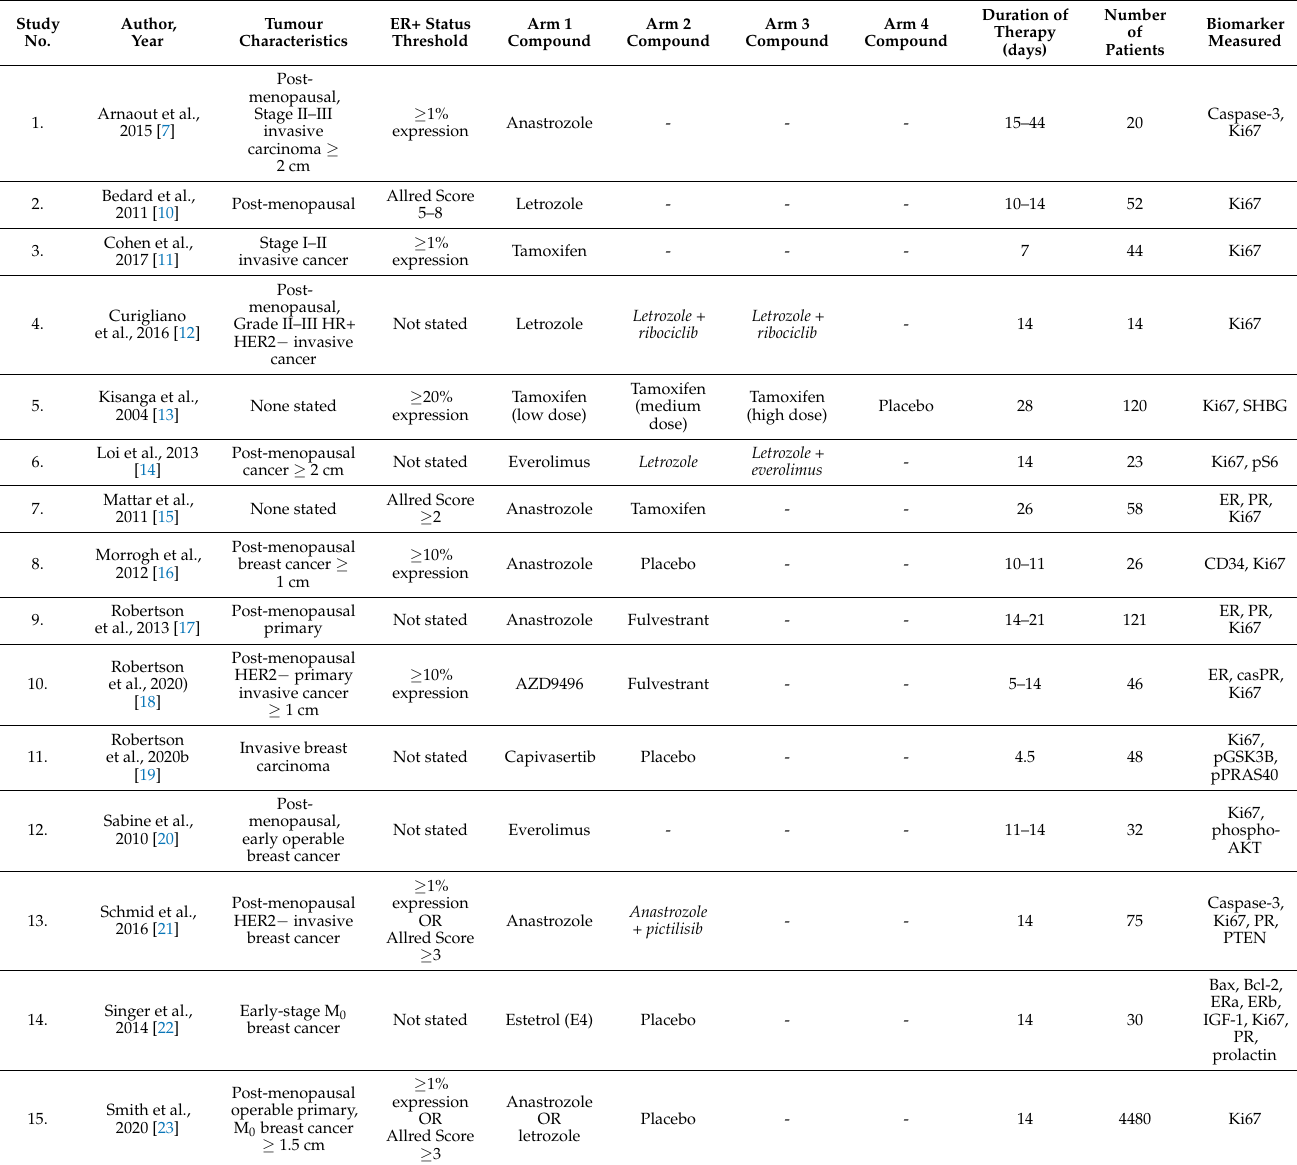
Table 1. Summary of the study characteristics of the 15 eligible WoO trials included in the systematic review. Treatments arms, which are italicised, were ineligible for